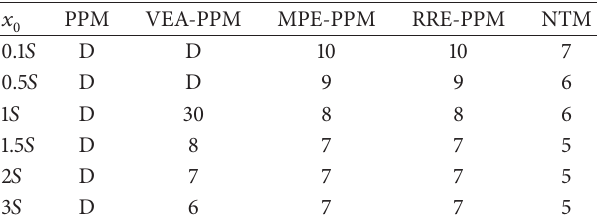
Table 2: Results of the case 𝑚 = 1000